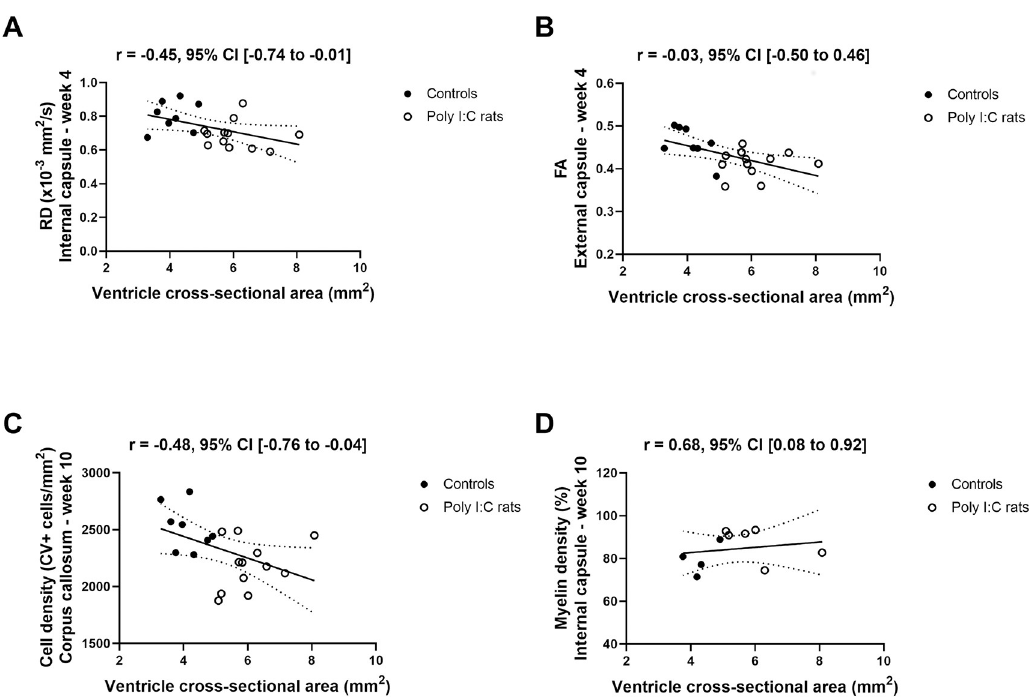
Fig 8. Estimates of the Pearson correlations with ventricle cross-sectional area and their 95% confidence intervals (CI). Radial diffusivity (RD) in the internal capsule at week 4 (A) and fractional anisotropy (FA) in the external capsule at week 4 (B); cell density at week 10 in the corpus callosum (C) and myelin density at week 10 in the internal capsule (D) across the whole sample. Control (•) and poly (I:C) rats ( � ) are indicated. Bonferroni-adjusted confidence intervals are reported in the S1